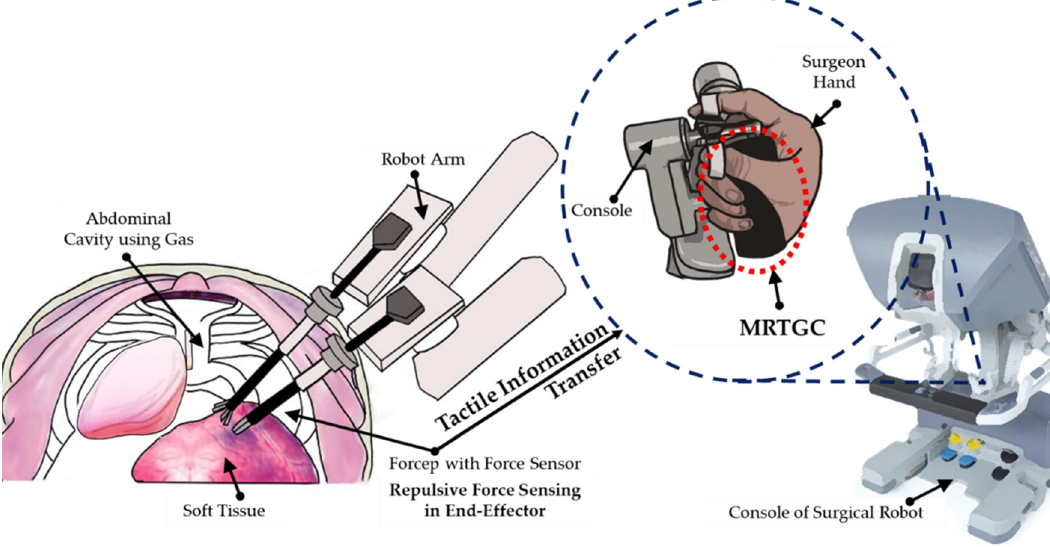
Figure 1. Schematic diagram of the overall control system integrated with the proposed MRTGC on the console of a surgical robot .